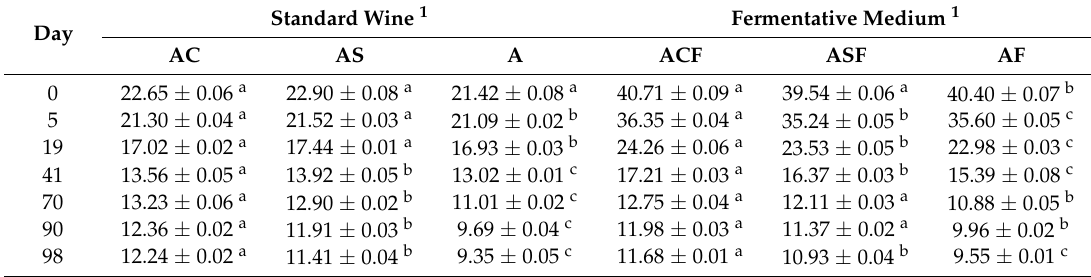
Table 2. Evolution of the mean value of chroma (C* ab ) in the model